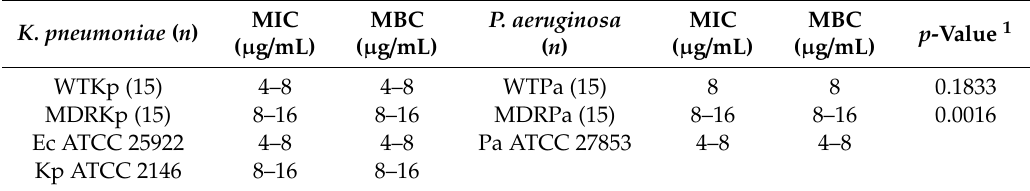
Table 3. In vitro antibacterial and bactericidal activity of ∆ M2 against wild-type and multidrug-resistant strains of K. pneumoniae and P. aeruginosa